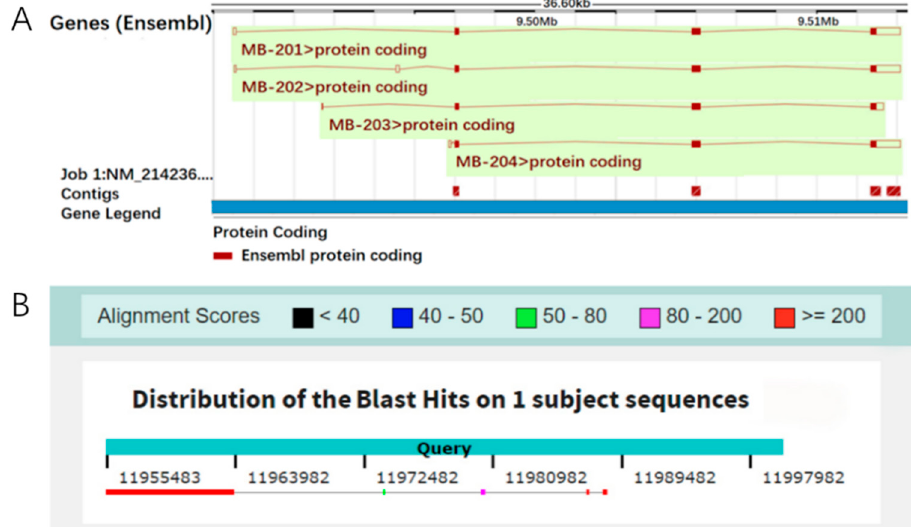
Figure 1. The localization of Mb gene on the porcine reference genome. ( A ) genomic structure information of Mb transcripts on the primary assembly of Wuzhishan mini-pig; ( B ) the localization of Mb gene on chromosome 5 of the porcine reference